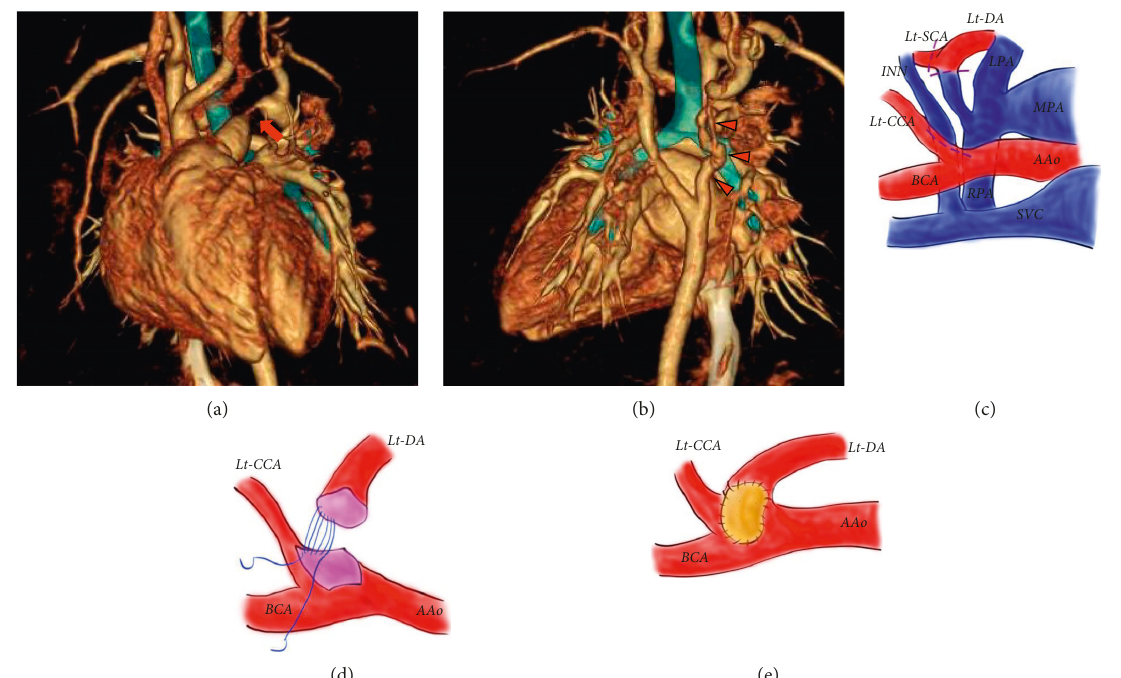
Figure 2: (a, b) Contrast-enhanced three-dimensional computed tomography images at 53 days of age. (c–e) Schema of the aortic re- construction. (a) The frontal view. This image shows the narrowing of the patent ductus arteriosus (red arrow). (b) The rear view. Red small arrowheads indicate the right distal arch. The progression of narrowing and tortuousness of the right-sided aorta was shown compared to contrast-enhanced three-dimensional computed tomography images at 8 days of age. (c) The left aortic arch was interrupted, and the left subclavian artery arose from the left distal arch (interrupted aortic arch type B. Because there was a large gap, approximately 2cm, between the ascending aorta and left distal arch, the left subclavian artery was resected from the distal arch to perform a direct anastomosis. The patent ductus ateriosus and adjacent ductal tissue were resected from the descending aorta. (d) The ascending aorta was cut back up to the undersurface of the proximal side of the left common carotid artery. The left distal arch was directly anastomosed to the undersurface of the arch (extended aortic arch anastomosis). (e) Anterior patch augmentation for the aortic arch was performed using glutaraldehyde-treated autologous pericardium. Superior vena cava (SCV), innominate vein (INN), ascending aorta (AAo), brachiocephalic artery (BCA), left common carotid artery (Lt-CCA), left subclavian artery (Lt-SCA), left distal arch (Lt-DA), main pulmonary artery (MPA), right pulmonary artery (RPA), left pulmonary artery